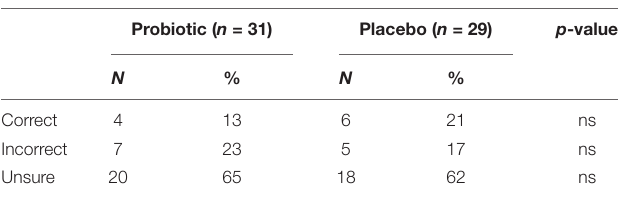
Within group Active vs. placebo between